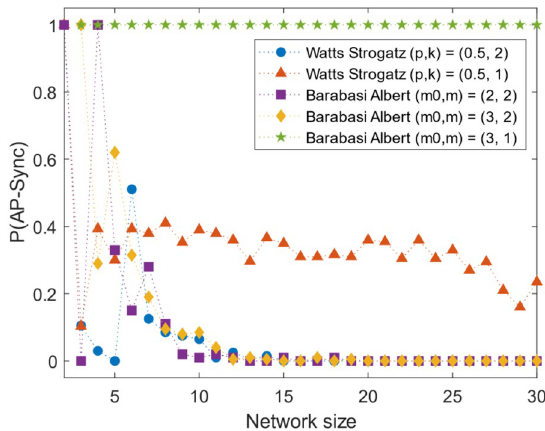
Figure 4. Results with alternative random-graph algorithms. Networks generated using the Barabási-Albert (BA) algorithm and the Watts-Strogatz (WS) algorithm are shown for different parameter values. The WS networks generated were generated from = k 1 and = k 2 connected nearest neighbors on each side initially. . =